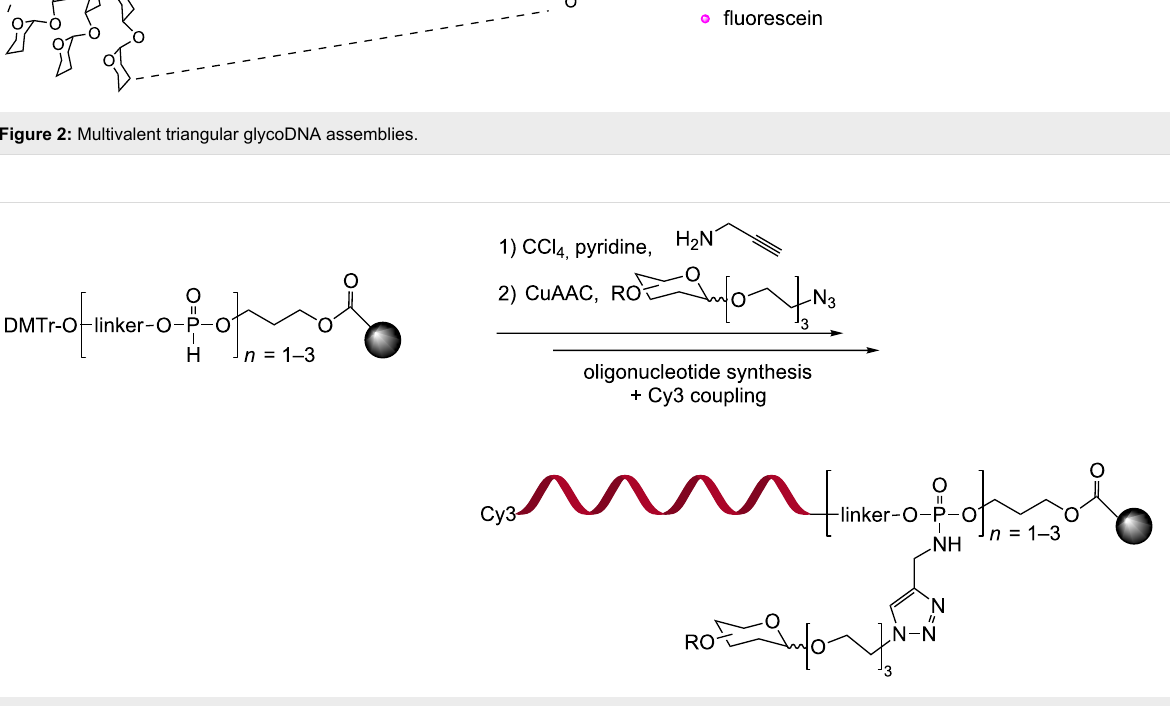
strand at the 2’-position using an azido and a bromo-modified thymidine 6 and 7 (Scheme 5)